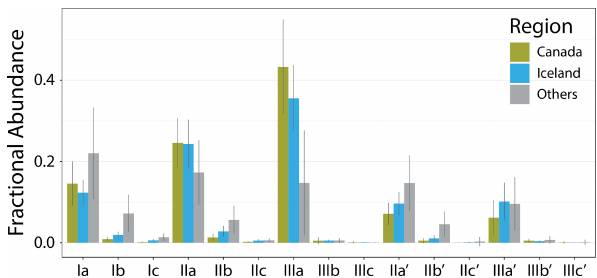
Figure 4. Average fractional abundances (calculated within the standard Full set) of new samples from Canada and Iceland com- pared to the average of the other samples in this study